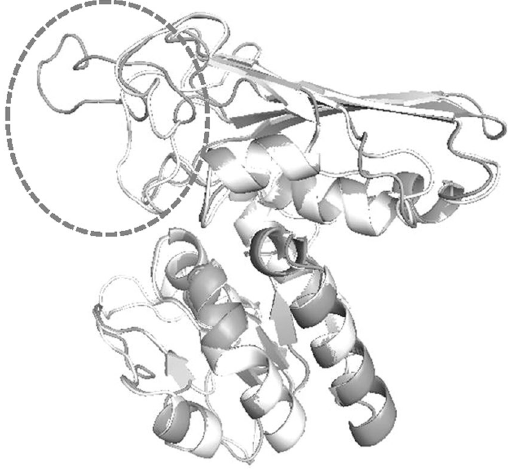
Figure 5. Structural alignment of KpnAspDH and DelAspDH. The structures of the two are shown in white and grey, respective. The position of the big loops is shown in dashed